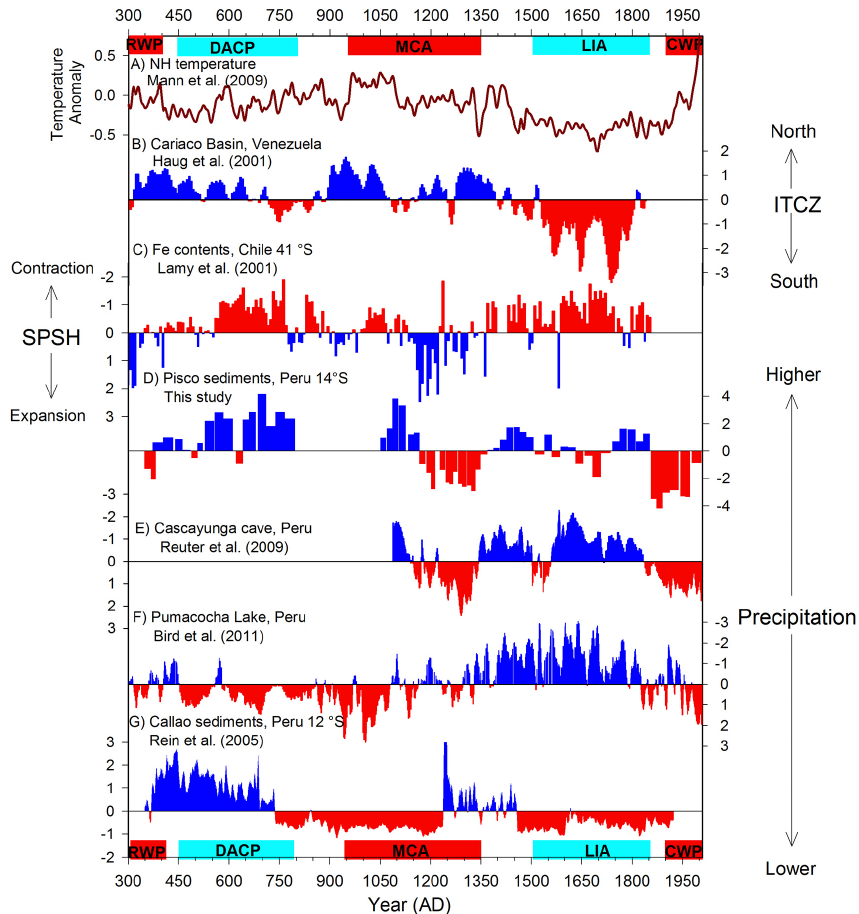
Fig. 3. Precipitation proxies during the last two millennia and selected records from the literature. (A) 10-point average of the “Northern Hemisphere land error-in-variable (EIV) composite” (Mann et al., 2009). (B) 3-point average of Ti% in Cariaco Basin (Haug et al., 2001). (C) 3-point average of Fe intensity in a marine sediment core off Chile ( ∼ 41 ◦ S), where higher (lower) values of Fe indicate lower (higher) precipitation and thus a more poleward (equatorward) position of the westerlies. Relative low iron contents are related to enhanced runoff from the iron-poor coastal ranges when the westerlies were positioned over the core position (Lamy et al., 2001). Consequently, a more poleward (equatorward) position of the southern westerlies and the south rim of the SPSH are interpreted to represent a SPSH expansion (contraction). (D) Averaged terrestrial runoff record obtained from the standardized Al and Ti values. (E) 5-point average of Cascayunga cave speleothem rainfall δ 18 O (Reuter et al. 2009), . (F) 5-point average Pumacocha δ 18 O cal record (Bird et al., 2011). (G) A proxy for lithic concentration in a marine sediment core retrieved off Callao ( ∼ 12 ◦ S) (Rein et al., 2004, 2005). The series were smoothed using a running mean when indicated and then normalized to a standard Z score. The colored boxes at the top and bottom of the figure indicate the Roman Warm Period (RWP), the Dark Ages Cold Period (DACP), the Medieval Climate Anomaly (MCA), the Little Ice Age (LIA) and the Current Warm Period